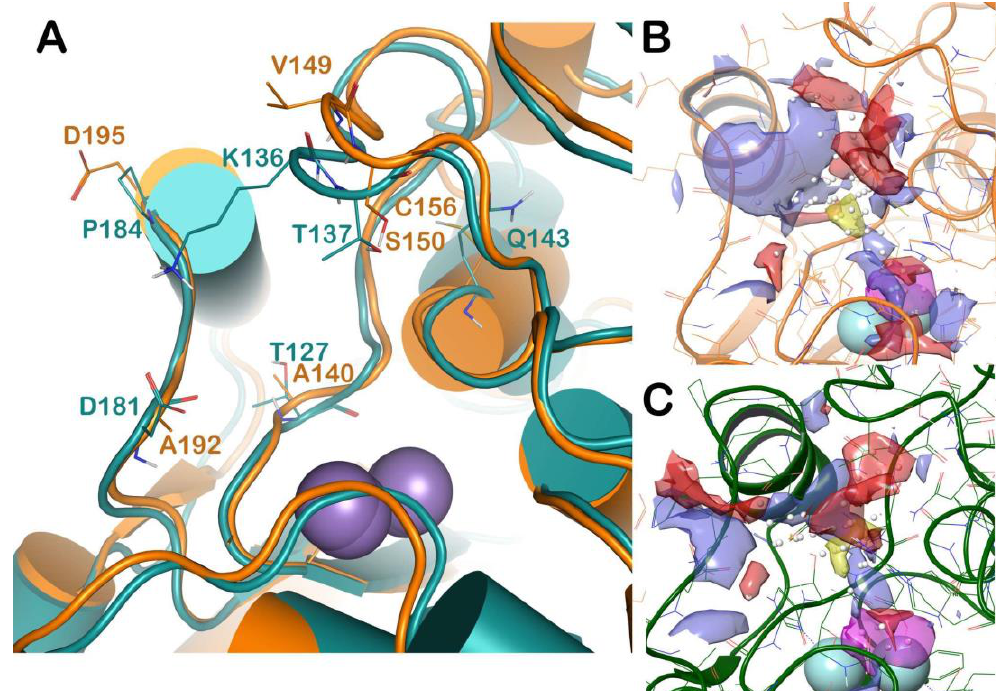
Figure 4. ( A ) Superposition of L-ARG (orange cartoon) with a homology model of B-ARG (dark green cartoon). The changed residues were highlighted, and reported as lines. The picture was generated by PyMOL (The PyMOL Molecular Graphics System, v1.8; Schrodinger, LLC, New York, NY, USA, 2015). ( B , C ) Output of the SiteMap calculation, highlighting the different surfaces of the two selected binding sites (L-ARG in orange cartoon; B-ARG in dark green cartoon). The pictures were generated by Maestro (Maestro, Schrödinger, LLC, New York, NY, USA, 2016).